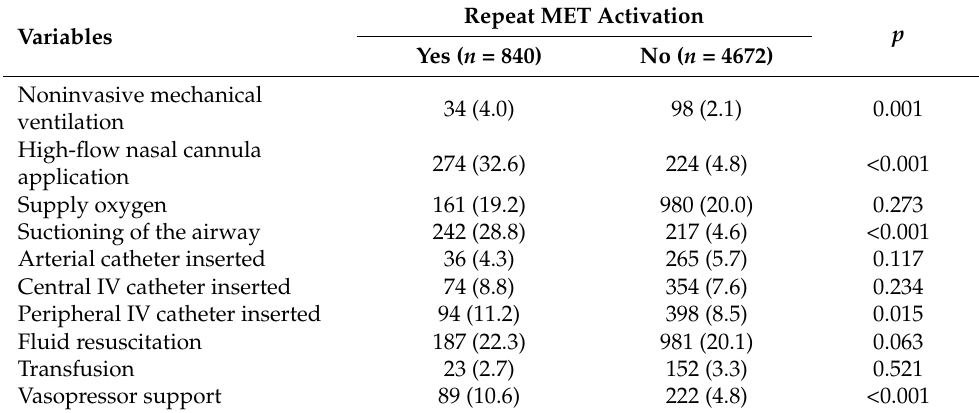
Table 2. Intervention of care during first medical emergency team